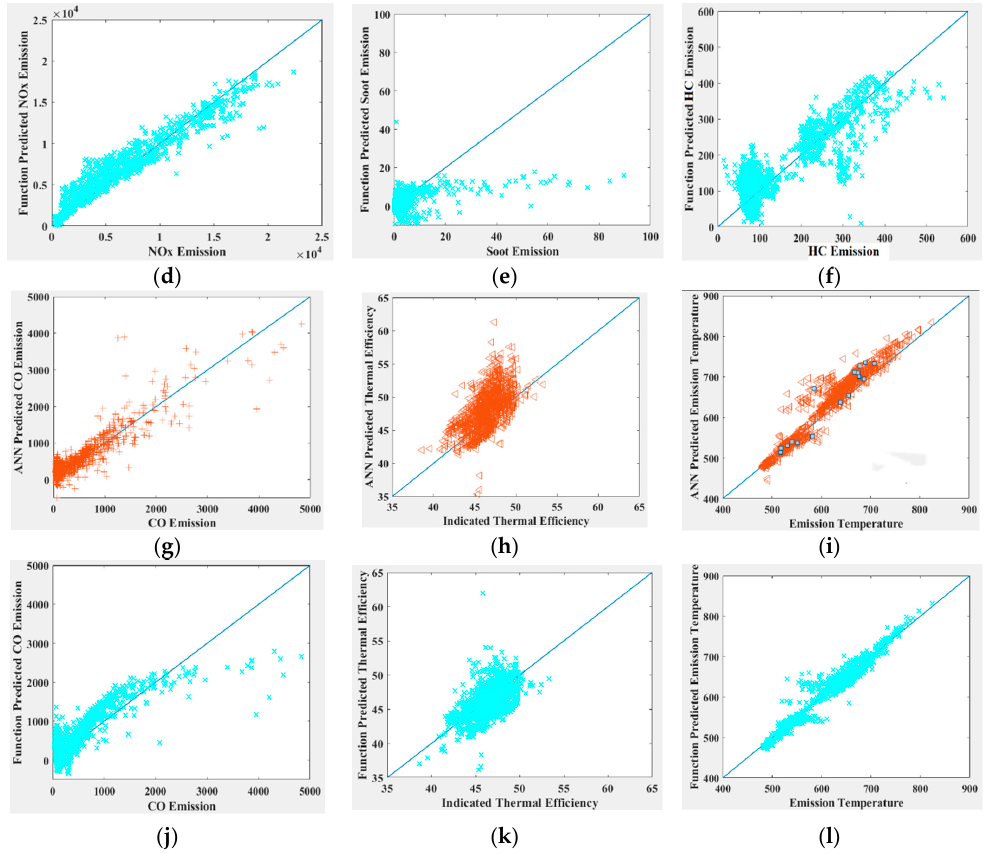
Figure 8. ( a ) NOx ( b ) Soot ( c ) HC ( d ) NOx ( e ) Soot ( f ) HC ( g ) CO ( h ) Thermal efficiency ( i ) Exhaust